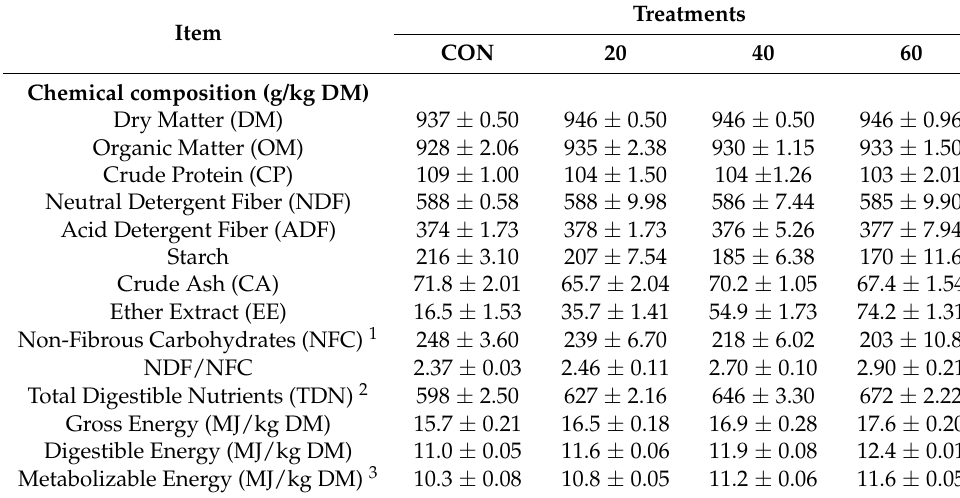
Table 2. Chemical composition of experimental diets.